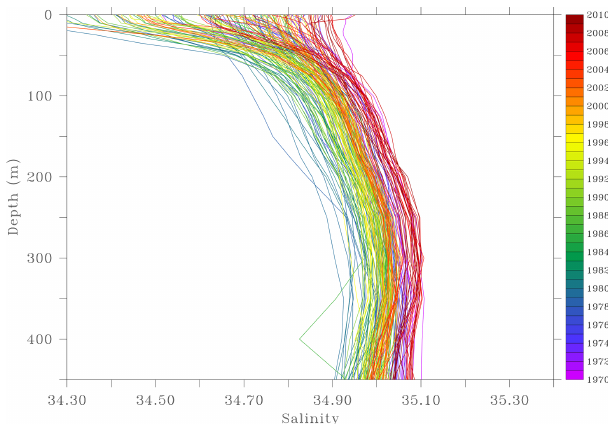
Figure 8. Seasonal averaged profiles of salinity on the most reliable area between 1970 and